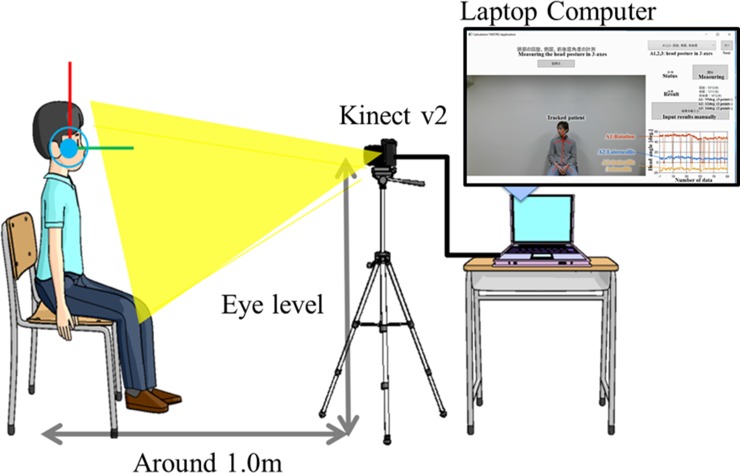
Study equipment.